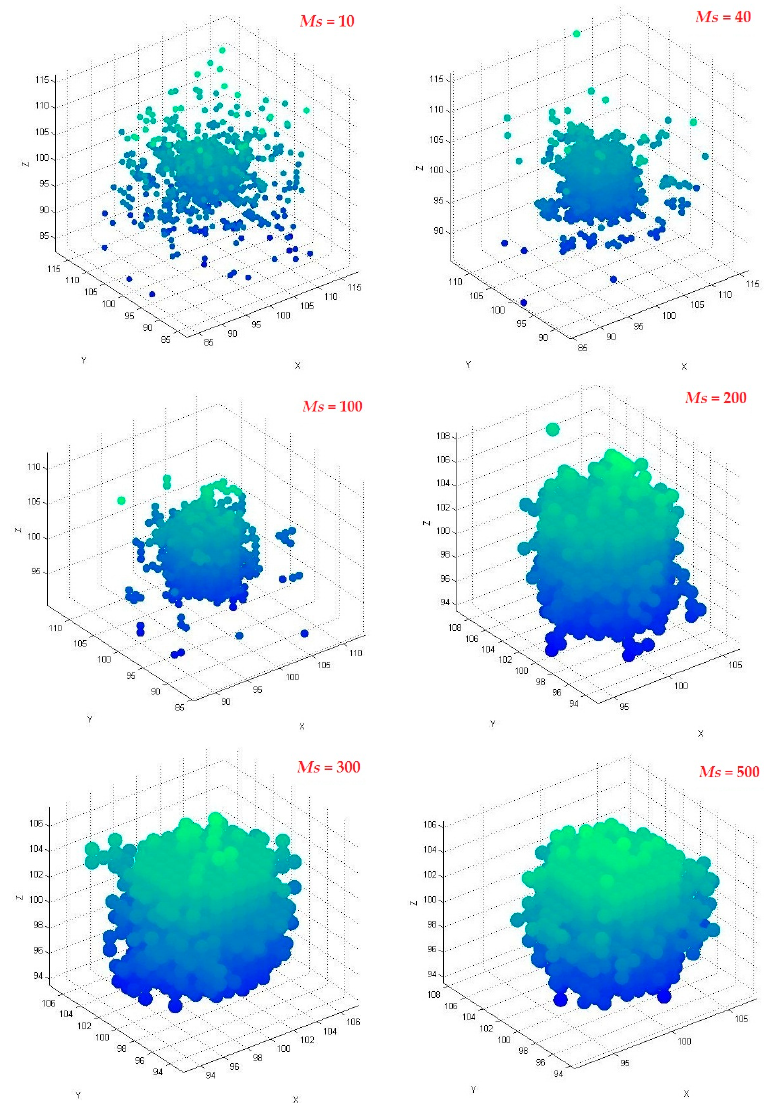
Figure 12. 3D DLA aggregates with diverse finite motion step numbers.